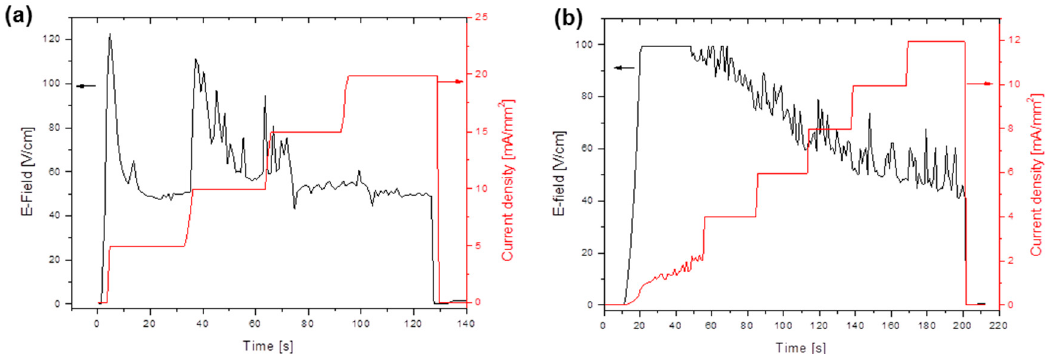
Figure 6. Electrical data for the two current ramps adopted in this work: up to 20 mA / mm 2 ( a ) and 12 mA / mm 2 ( b ).